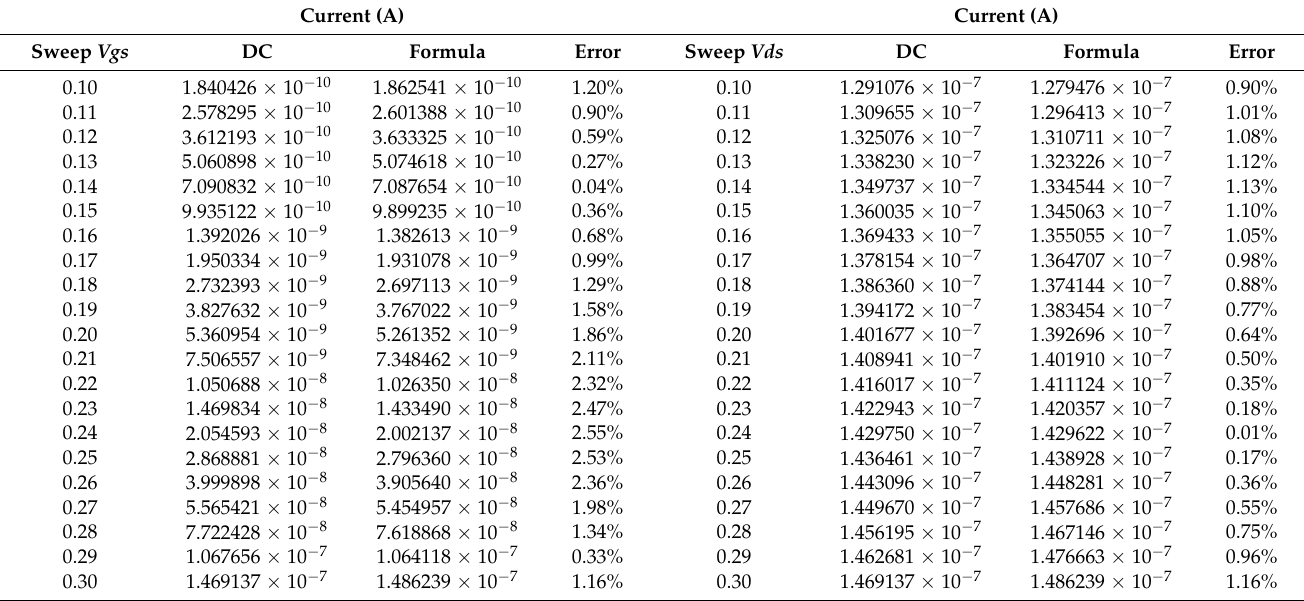
Table A5. Size 4: Current data compared with simulation